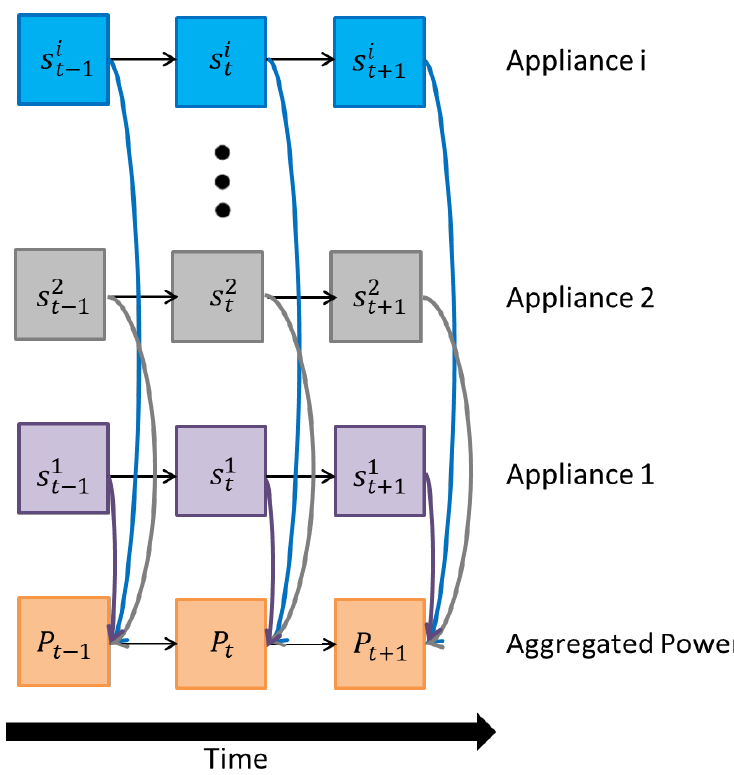
Figure 2. FHMM used in the NILM context. Inspired on [31,32].